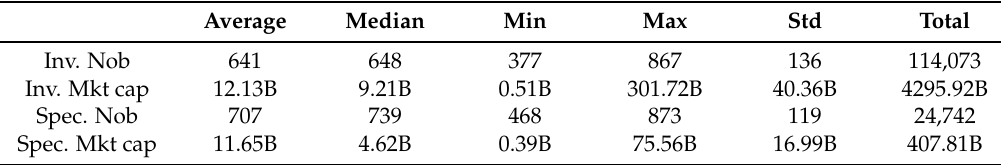
Table 1. Number of observations and market cap.